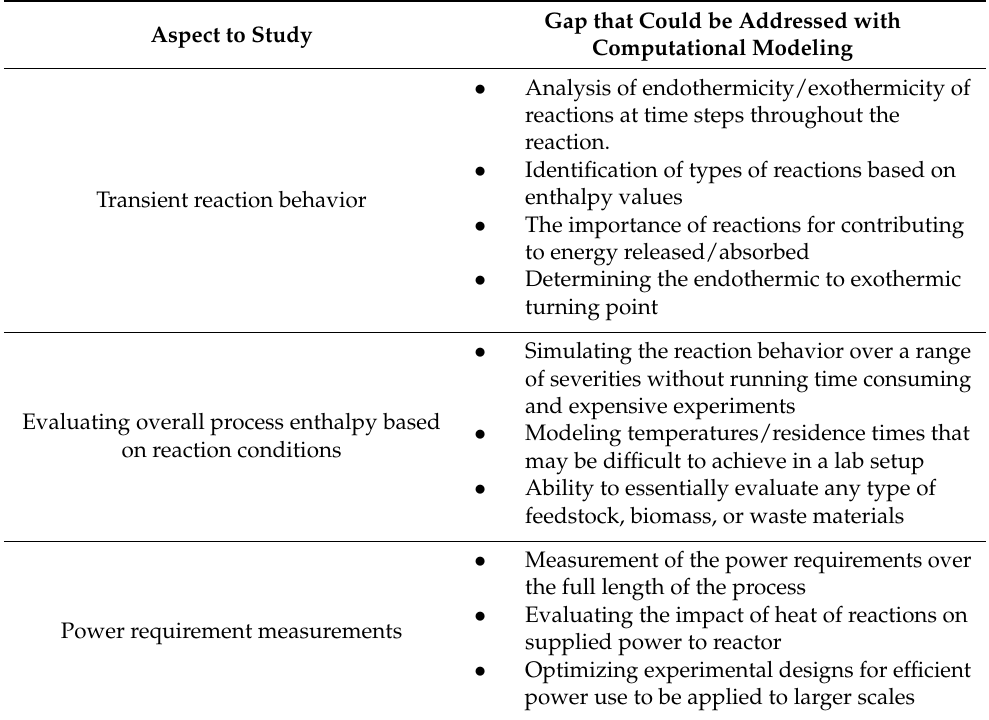
Table 2. Potential benefits of using computational models for HTC heat of